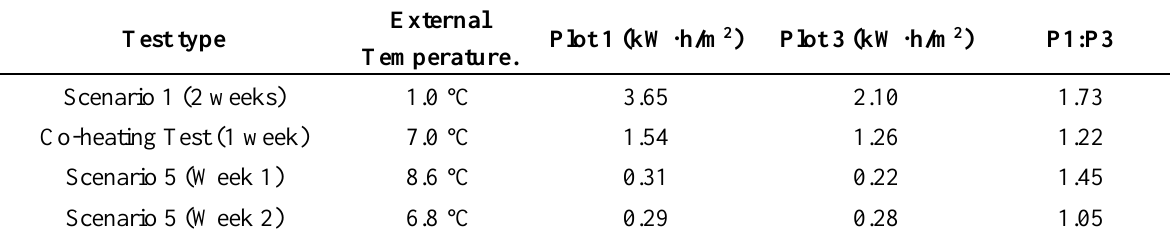
Table 2. Energy consumption SC1, co-heating and SC5, week 1 and week